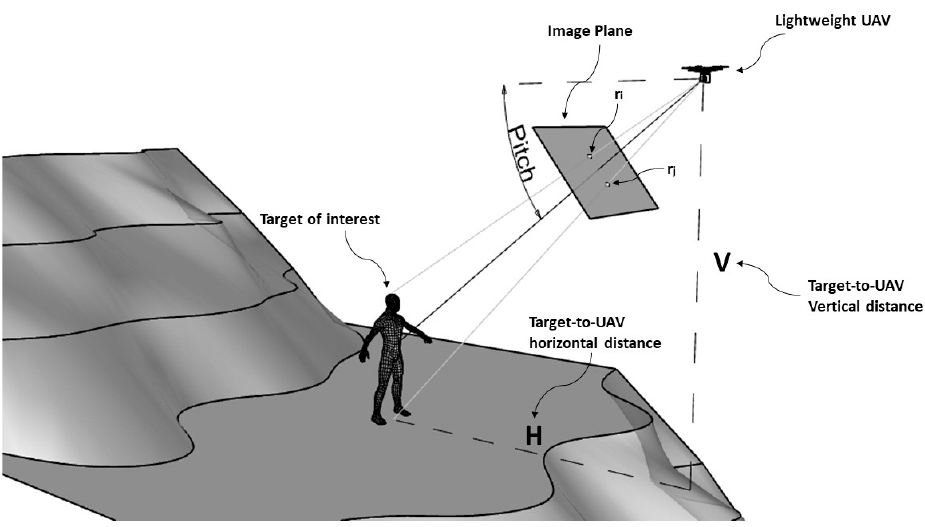
Figure 1. Graphical representation of the parameters required to calculate the height of the target of interest with a UAV using a pinhole model after image distortion correction. (Source: [3] with modifications).